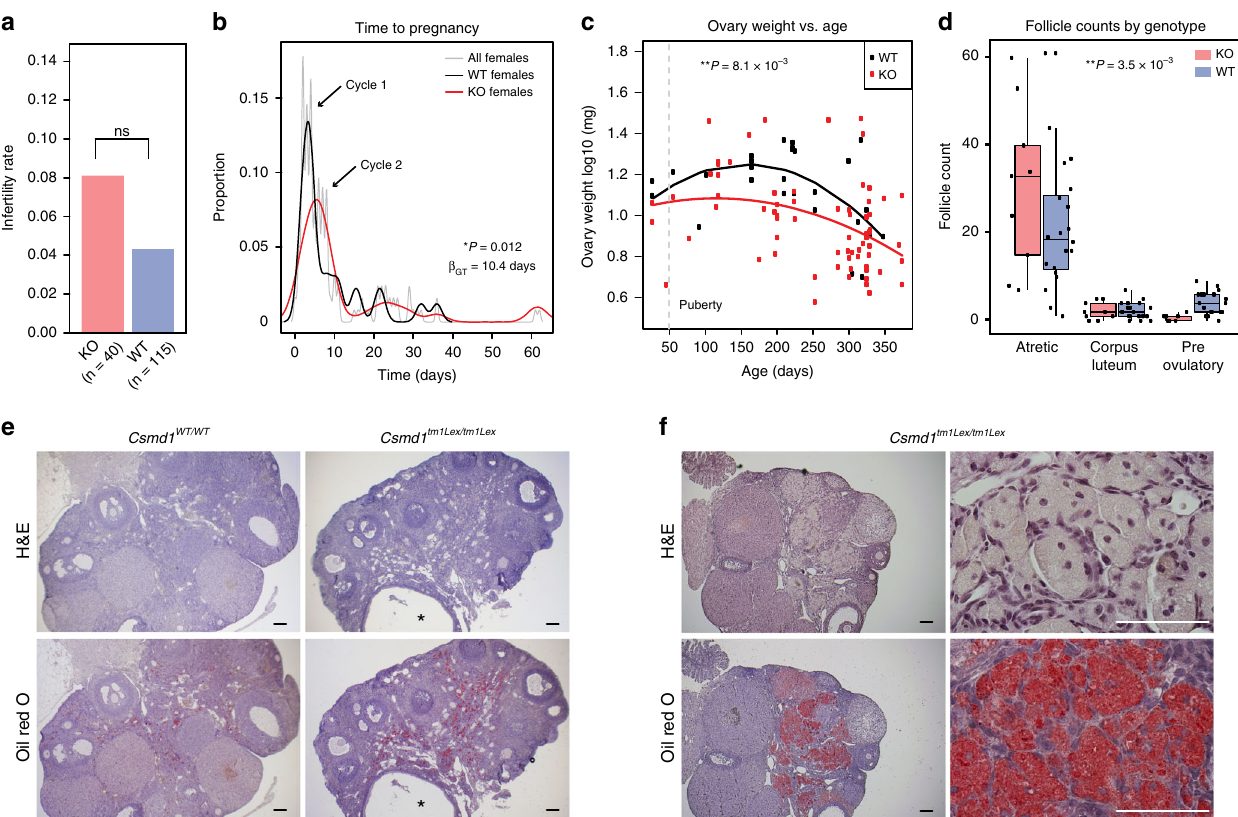
Fig. 5 Csmd1 knockout ovaries show reduced morphologic quality and reproductive performance. a Barplot depicting proportions of infertile Csmd1 wildtype (WT) vs. knockout (KO) females. In the population sampled ( n = 115 WT + 40 KO), Csmd1 genotype does not signi fi cantly predict infertility status in females (relative risk = 1.9, linear regression p -value > 0.05). b Probability density plot depicting female mating success over time, strati fi ed by maternal genotype (black = wildtype females; red = knockout females; gray = all females). The distribution is periodic, recapitulating the periodicity of the mouse female estrous cycle. Knockout females require signi fi cantly more cycles to achieve pregnancy ( β GT = 10.4, linear regression p -value = 0.01), with a small subset of females never achieving pregnancy. All statistical models account for confounders such as age, body weight, and male factors when appropriate (see Methods section). c Scatterplot depicting ovary weight versus age, strati fi ed by genotype (black = wildtype females; red = knockout females). The fi tted polynomial models are depicted as lines with color corresponding to genotype. Knockout females have signi fi cantly smaller ovaries than wildtype when controlling for age (quadratic regression p -value = 8.1 × 10 − 3 ). Gray hashed line demarcates rough onset of puberty in females. d Composition of follicles differs signi fi cantly between wildtype and knockout female ovaries, with signi fi cantly fewer pre-ovulatory follicles and signi fi cantly more atretic follicles in knockout (Hotelling t -test p -value = 3.5 × 10 − 3 ). Center line = median; hinges = upper and lower quartiles; whiskers = 1.5 × interquartile range. e Ovarian histology in a wildtype versus knockout female. Knockout ovaries were consistently enriched for foam cell macrophages, con fi rmed by Oil Red O stain in adjacent sections. We occasionally observed ovarian cysts in knockout females (asterisk). f Ovary from 336-day-old knockout showing extensive involvement of foam cells occupying 40% of the tissue (left). High magni fi cation of ovary section from same animal; top shows multinucleated appearance of foam cells, bottom is Oil Red O stain of adjacent section (right). All scale bars = 100 μ m. Source data are provided as a Source Data fi le